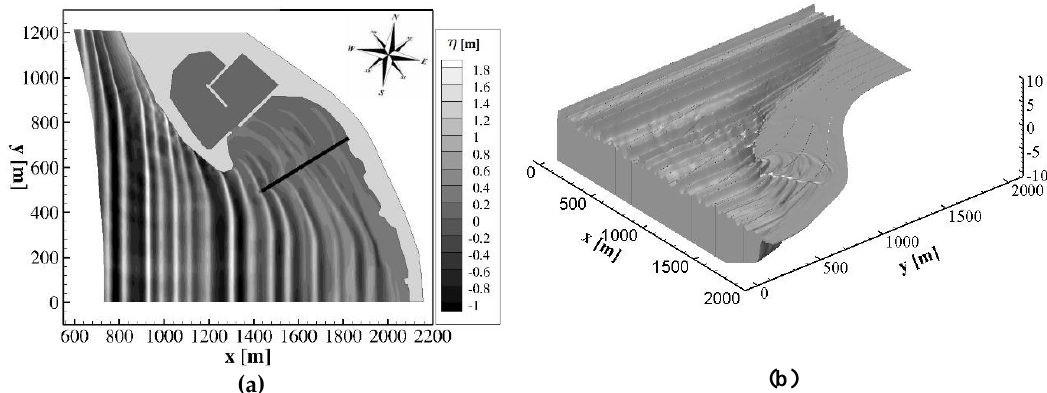
Figure 10. ( a ) Plan view and ( b ) three-dimensional view of an instantaneous wave field obtained by the numerical simulation of the significant wave event in the coastal region of Cetraro harbour in the project configuration.